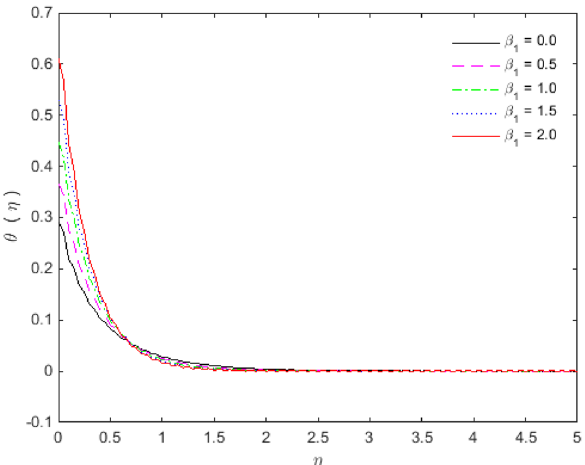
Figure 4. Temperature profile for β 1 .